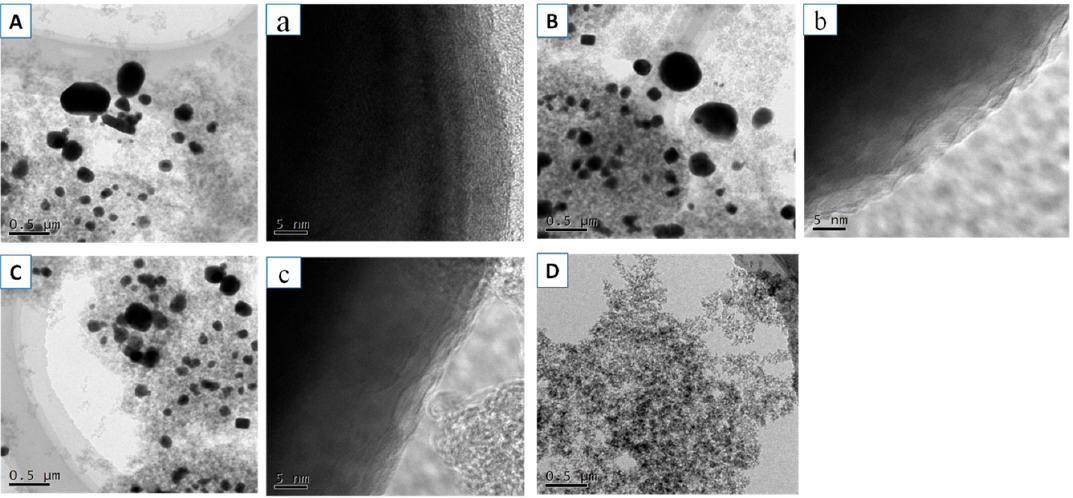
Figure 7. TEM images of ( A ) CA-Fe, ( B ) CA-Cr, ( C ) CA-Cu, and ( D ) Blank, HRTEM images of ( a ) CA-Fe, ( b ) CA-Cr and ( c ) CA-Cu.